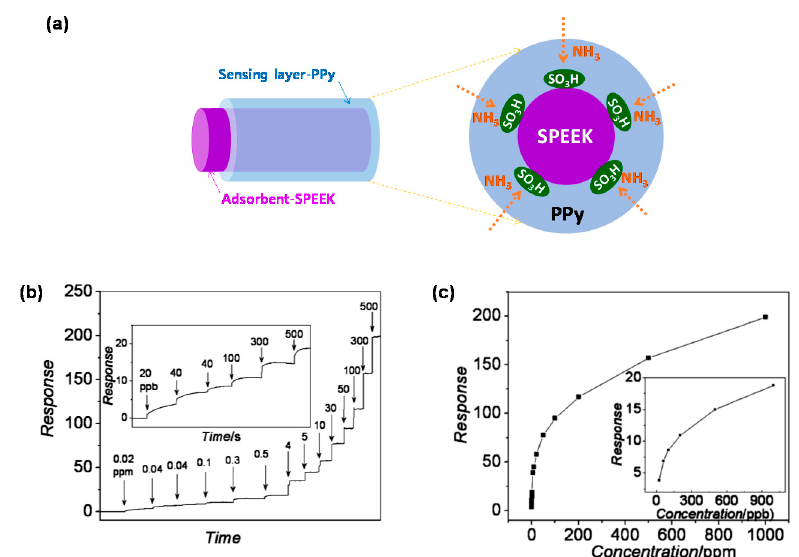
Figure 10. ( a ) Illustration of the SPEEK/PPy core-shell nanofibers for NH 3 sensor; ( b ) real-time responses to NH 3 in the range of 0.02 − 500 ppm (inset: the concentration range of 20 − 500 ppb); ( c ) the sensor response as a function of the NH 3 concentration (inset: the response curve in the range of 20 − 1000 ppb). Reprinted with permission from [80]. Copyright 2012, American Chemical Society.